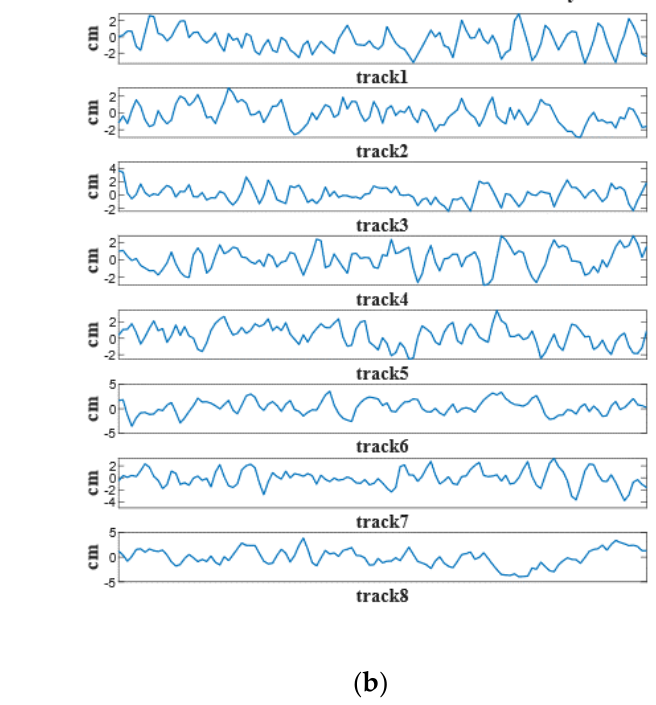
( b ) Figure 8. The working trajectories of autonomous vehicles controlled by ( a ) EfiMPC, and ( b ) NMPC. To finish the farming tasks quickly is not enough; it is also necessary to satisfy the